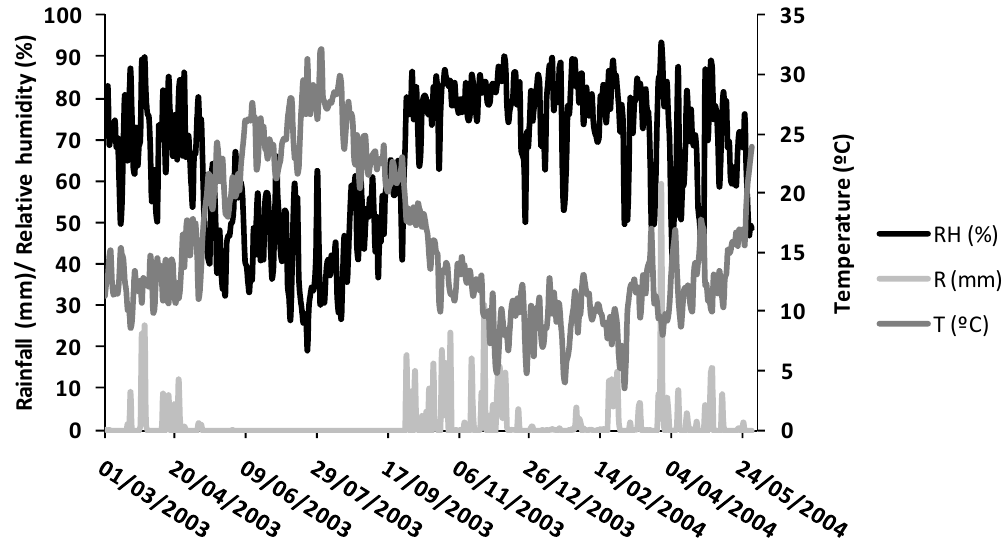
Figure 1. Rainfall (R, light grey line), relative humidity (RH, black line) and air temperature (T, dark grey line) in Sierra de Yeguas (Málaga), the location with the closest meteorological station from the location of the Trials II and III (15 km away). Meteorological data were registered from 1 March 2003 to 31 May 2004.